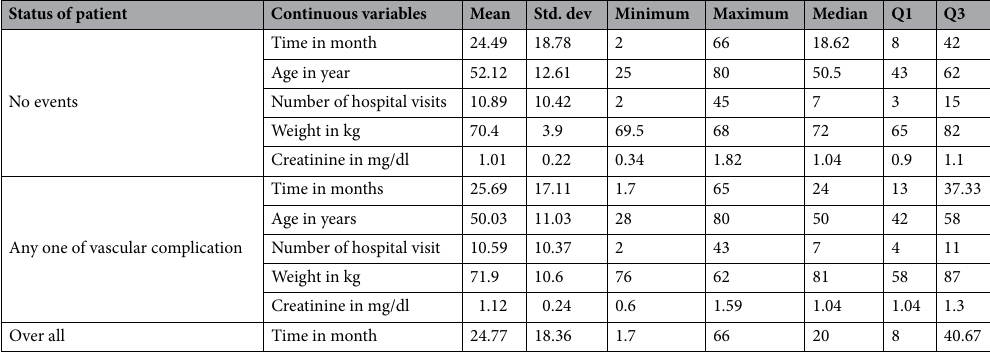
Table 1. Descriptive statistics for baseline continuous variables of T2DM patients under Anti diabetes drug in FHRH, December 2011–March 2016.